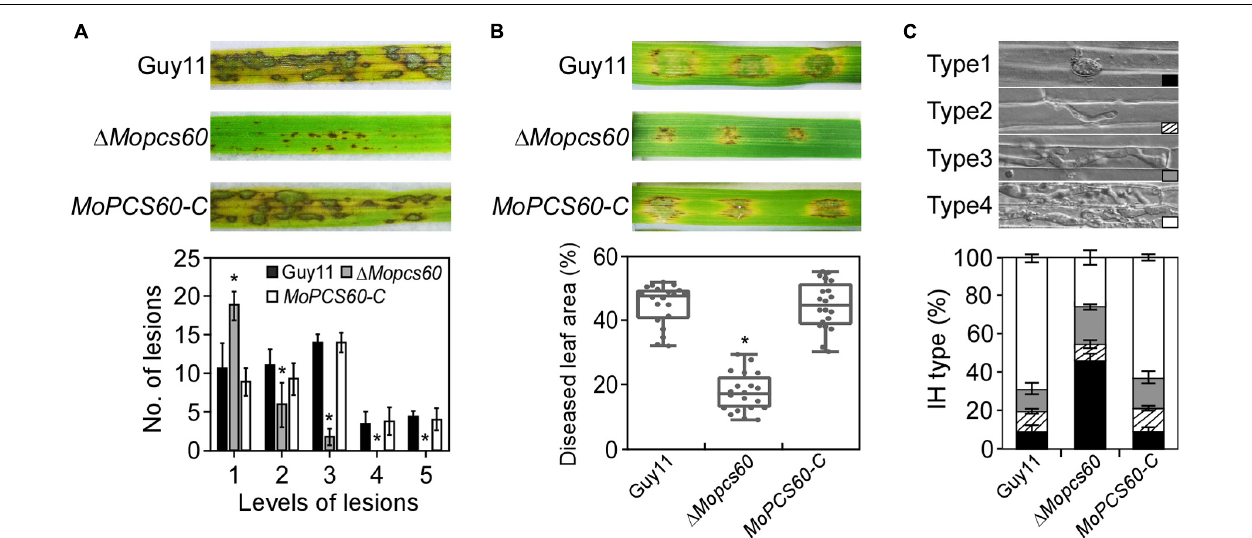
FIGURE 2 | The (cid:49) Mopcs60 mutant is defective in pathogenicity. (A) Conidial suspensions were sprayed onto rice seedlings and examined at 5 dpi (days postinoculation) (Top). Lesion types were counted within an area of 4 cm 2 leaf from each strain (Bottom). Error bars represent the standard deviations of three replicates; asterisk represents significant difference (* p < 0.01). (B) Conidial suspensions were inoculated onto detached barley leaves and examined at 5 dpi (Top). Diseased leaf area (Bottom) was analyzed by ImageJ (Media Cybernetics Inc., Shanghai, China). The percentage was represented by a box-dot-plot. Statistical analysis was performed using GraphPad Prism 8.0.1, and asterisk represents significant difference (* p < 0.01). (C) Detached rice sheaths were injected with conidial suspensions. IH types were counted and statistically analyzed at 32 hpi. Error bars represent the standard deviations of three